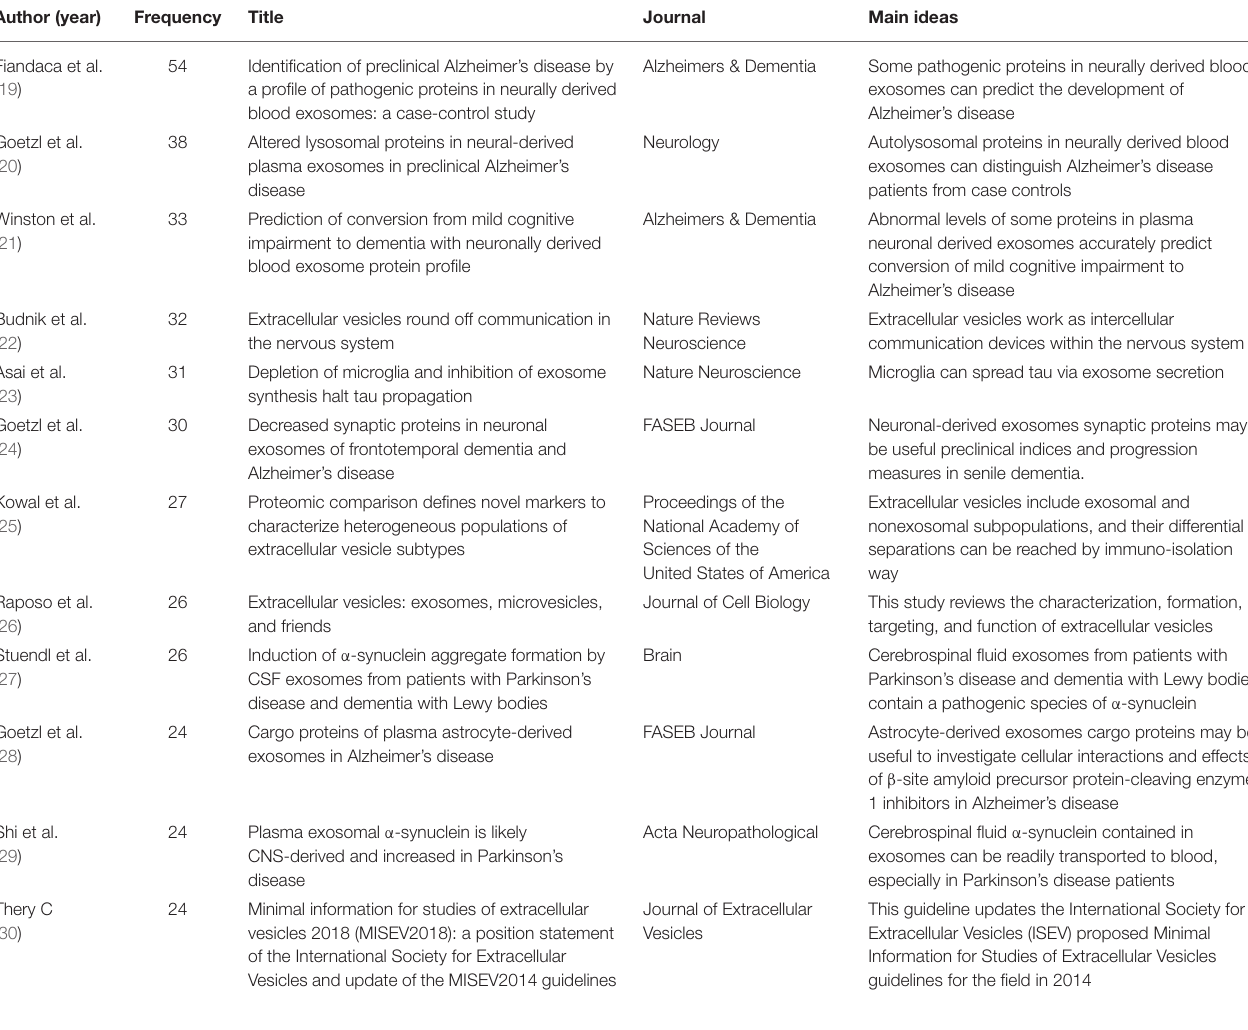
TABLE 4 | Summary of the top 12 most-cited articles about exosomes in the field of neuroscience from the co-citation analysis results.